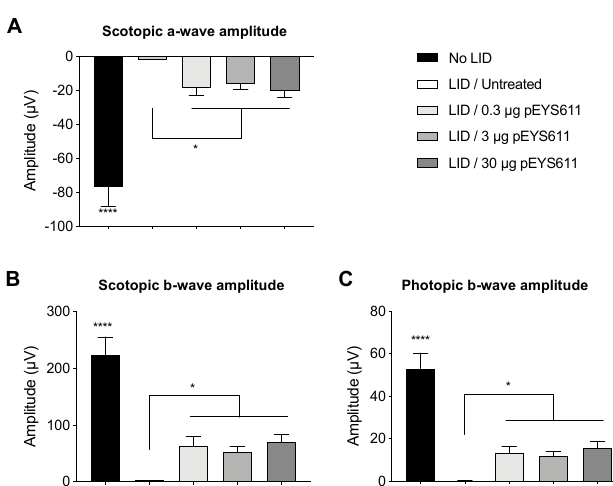
Figure 4. pEYS611 maintains retinal function in the rat LID model. Rats received a single ciliary muscle electrotransfection of pEYS611 at the dose of 0.3, 3, or 30 µg/eye on D-3 or left untreated ( n = 8 animals/group). Except for unexposed animals (no LID), retinal degeneration was induced on D0 by 24 h of bright light exposure (6500 lux). Dark- and light-adapted ERG responses were recorded simultaneously from both eyes on D8. ( A , B ) Average amplitude (µV) of scotopic a-and b-waves from ERG responses elicited by a stimulus intensity of 3 cd·s/m 2 and ( C ) amplitude of photopic b-wave from ERG responses elicited by a stimulus intensity of 10 cd·s/m 2 are presented as mean ± sem. * p < 0.05; **** p < 0.0001 using a repeated measure mixed model and determination of confidence intervals versus LID/untreated group.